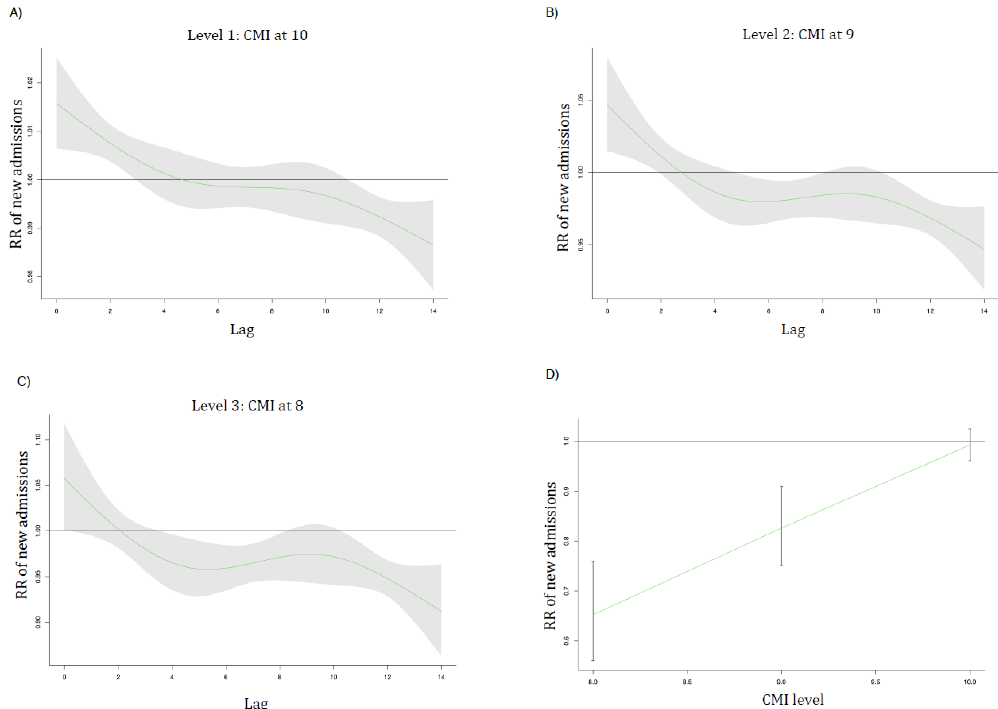
Figure 3. The lag curves (in days) representing the relative risk (RR) of new admissions with a shaded 95% CI for each future day following a decrease in CMI at level 1 (A), level 2 (B), and level 3 (C). (D) represents the overall reduction in hospitalization with each level of CMI. Level 1 is CMI = 10, level 2 is CMI = 9, and level 3 is CMI = 8. Int. J. Environ. Res. Public Health 2021 , 181 , 560